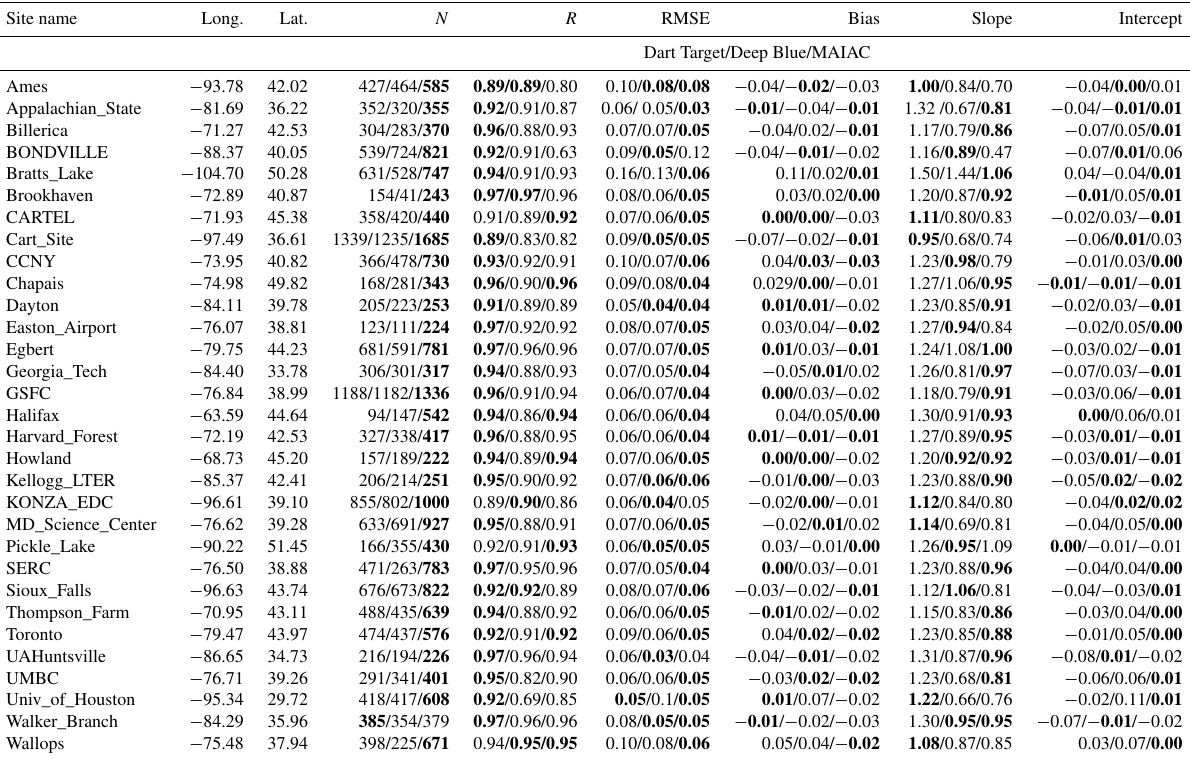
Table 3. Statistical measures of MODIS–AERONET AOT (470nm) matchups for sites in eastern North America. Numbers in bold indi- cate relatively best performance in the respective measures of fit between satellite and ground AOTs. Abbreviations are as follows. Long.: longitude; Lat.: latitude; N : number of satellite–ground matchups; R : correlation; RMSE: root-mean-square error between MODIS and AERONET; Bias: mean bias between the two datasets; Slope and Intercept: slope and intercept of the linear regression between MODIS and AERONET AOT